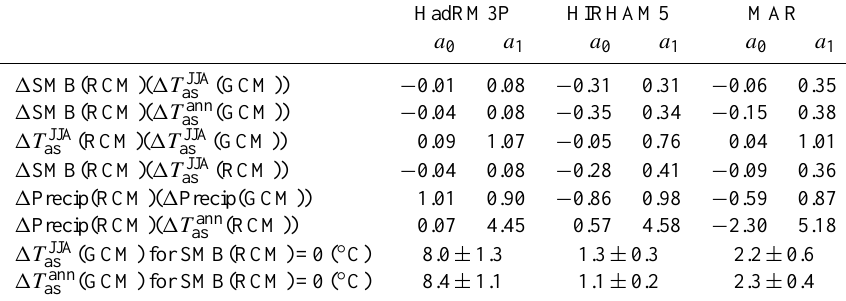
Table 7. Linear fit coefficients for relationships of the form Y = a 0 + a 1 X , denoted Y(X) to indicate dependence of Y on X , between decadal level equivalent) calculated from A1B-forced simulations. Changes are with respect to the 1980–1999 mean in the appropriate simulation for the recent past. GCM GrIS mean 1T JJA as at which SMB=0 according to the fitted linear function is also shown. Errors on 1T JJA as are calculated from the RMSEs on fitted